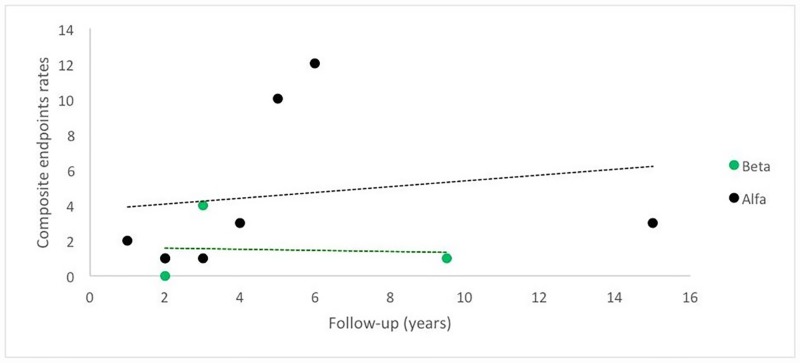
Progression of composite endpoints, according to ERT regimens throughout the years.